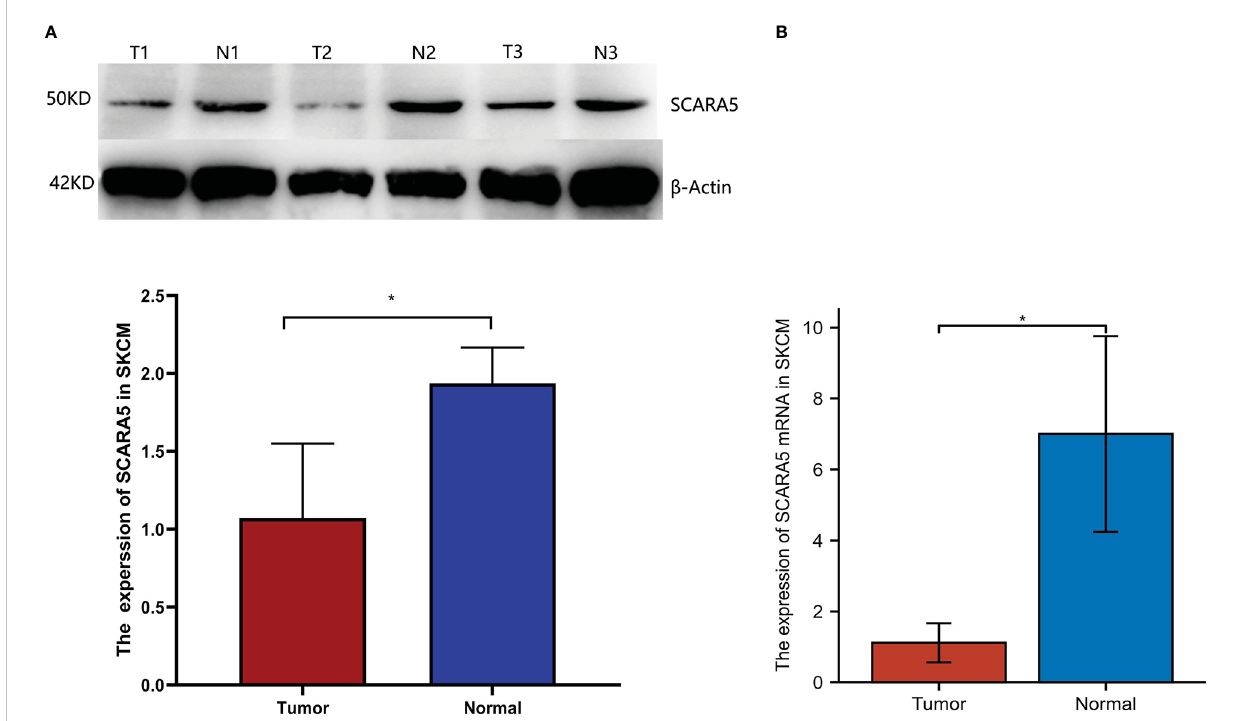
FIGURE 11 Expression of scavenger receptor class A member 5 ( SCARA5 ) in SKCM. Western blotting showing expression of SCARA5 in three SKCM tissues and adjacent normal tissues. Glyceraldehyde-3-Phosphate Dehydrogenase (GADPH) added as a loading control (A) . * p < 0.05. Reverse transcription PCR